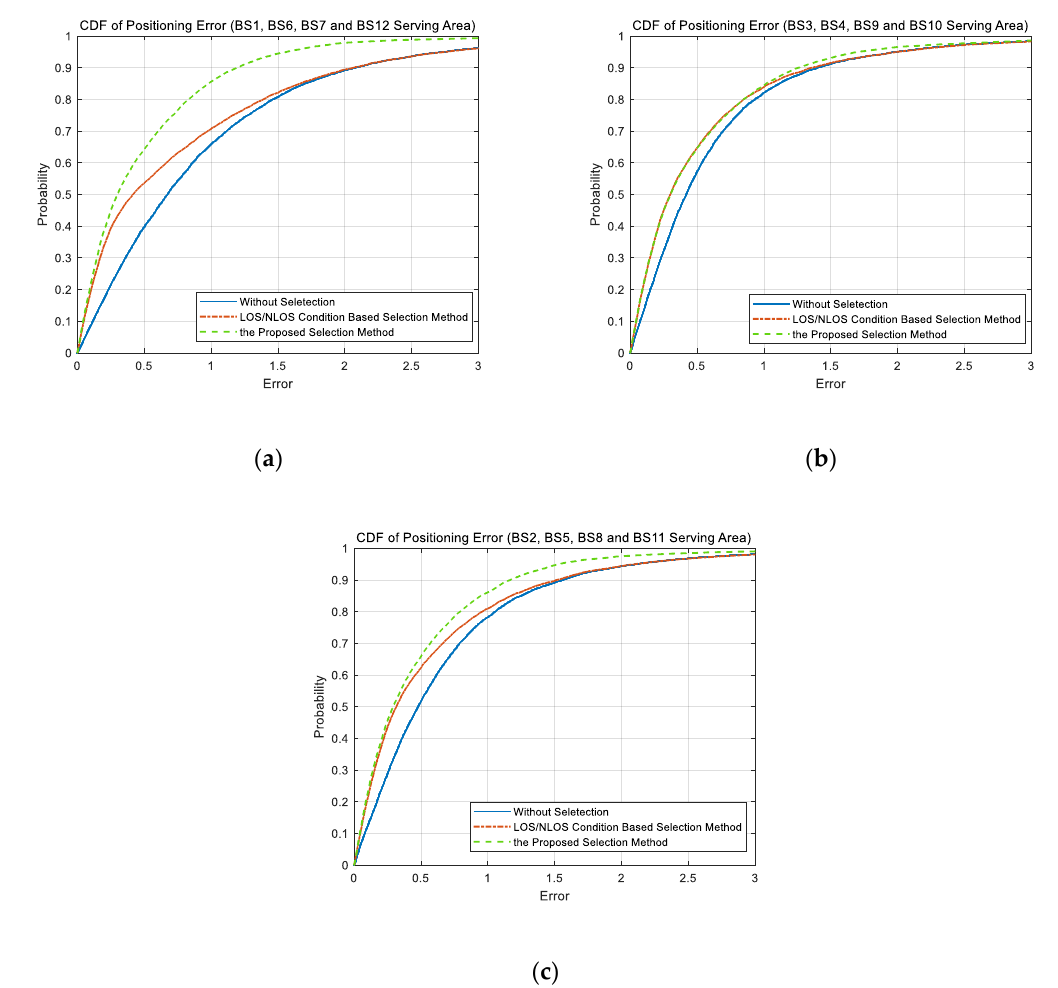
Figure 11. The CDF of positioning error with different BS selection methods in different regions. ( a ) The CDF in the side region. ( b ) The CDF in the center region. ( c ) The CDF in rest of the simulation scenario.